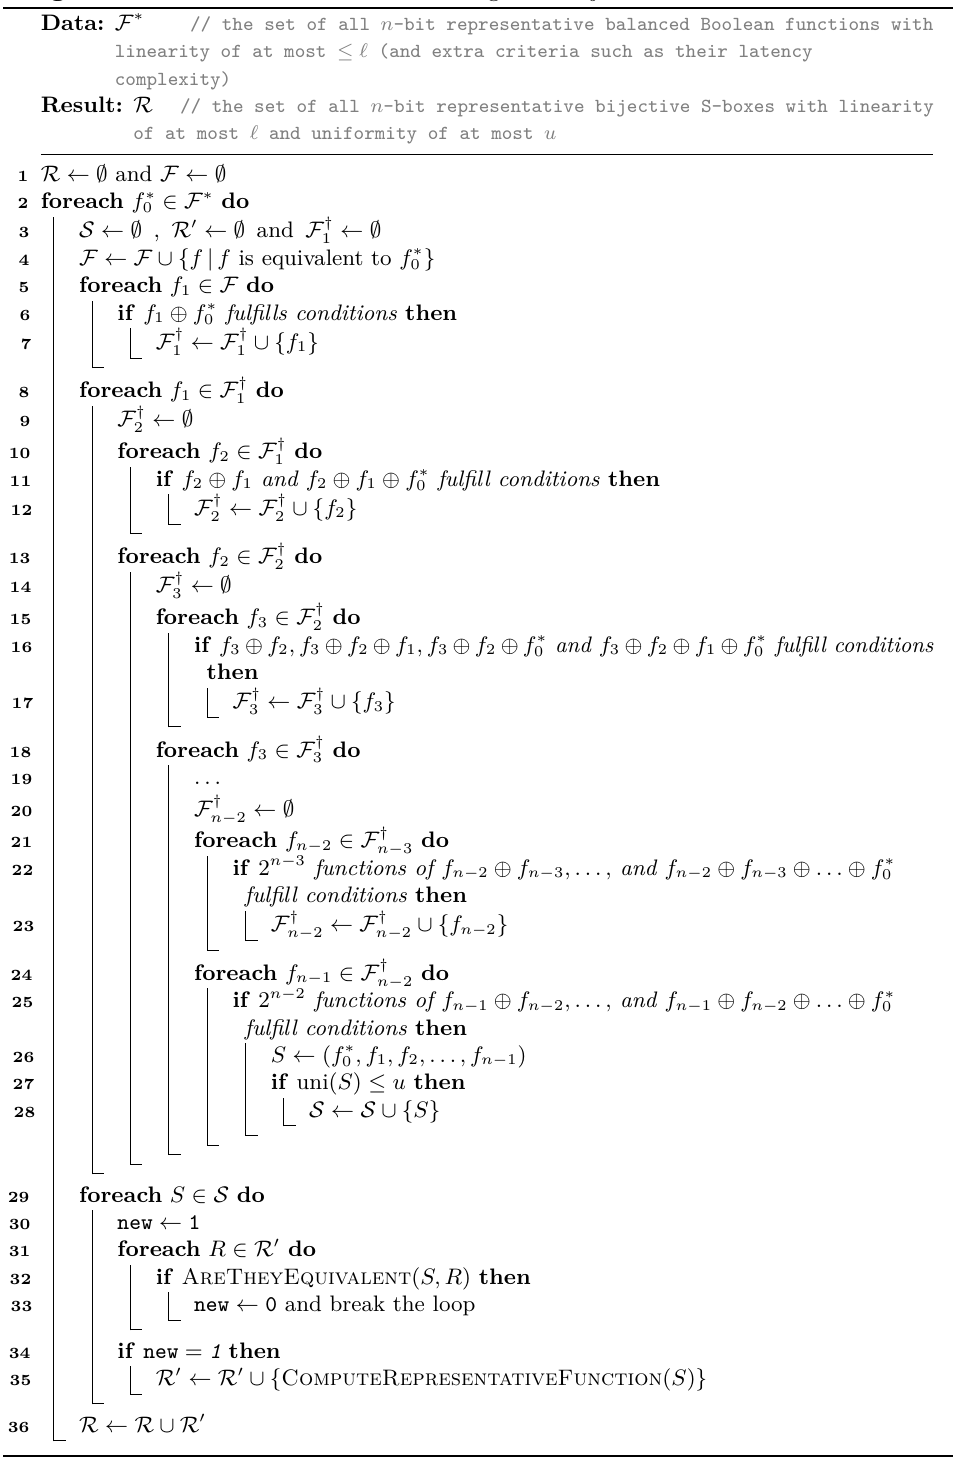
Algorithm 3: The new method of building n -bit bijective